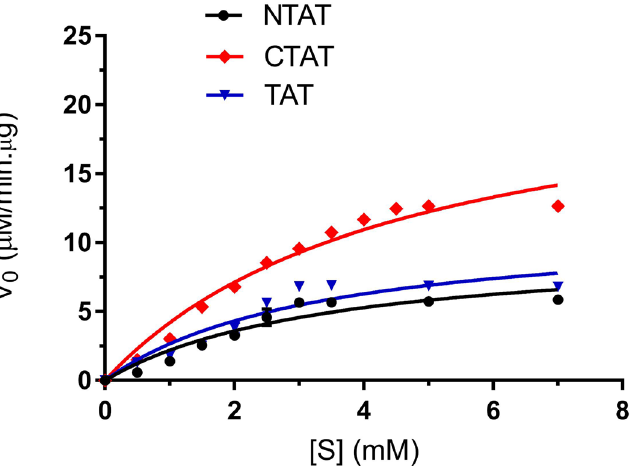
Figure 4. Michaelis–Menten Plot for NTAT, CTAT and TAT: The plot shows the activity of CTAT to be higher with respect to NTAT and TAT activity. The reduced activity of NTAT might be due to the lower binding of PLP to the active site cavity and residue K286. K m of NTAT, CTAT and TAT were calculated to be 3.468 ± 0.796 mM, 4.581 ± 0.627 mM and 3.282 ± 0.799 mM respectively. All experiments were conducted in triplicates and SEM was